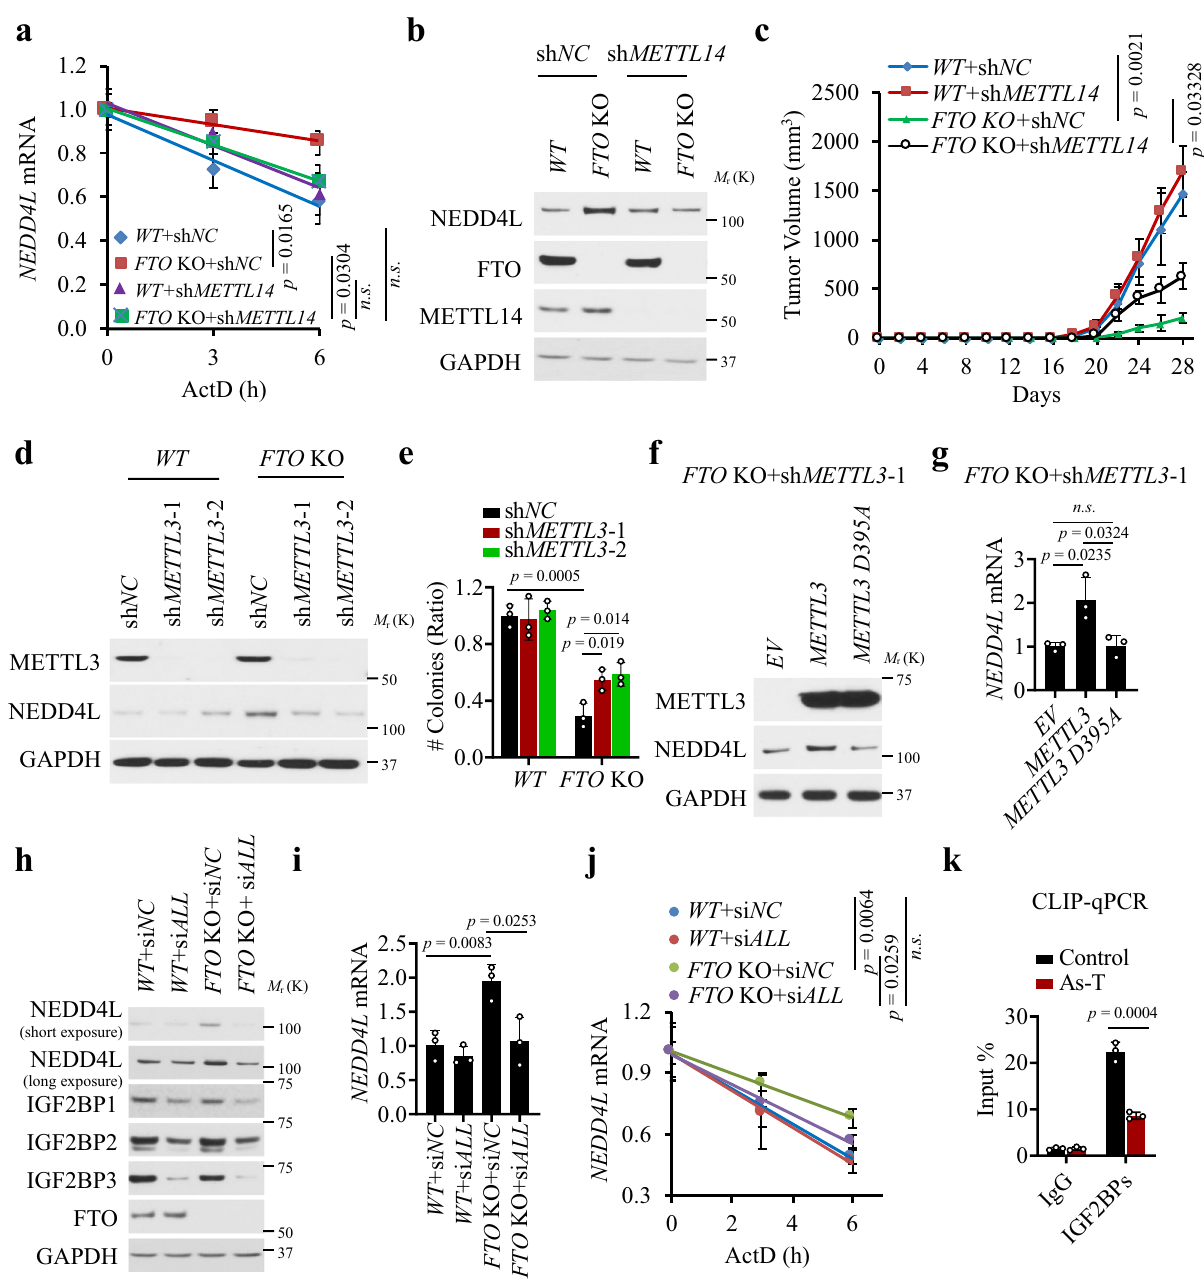
Fig. 5 FTO regulates NEDD4L and arsenic tumorigenicity through m 6 A. a qPCR analysis of NEDD4L mRNA stability in As-T cells with or without FTO deletion and/or METTL14 knockdown ( n = 3). b Immunoblot analysis of NEDD4L, METTL14, and FTO in cells as in a . c Tumor volume as in a following subcutaneous injection of cells as in a into NSG mice ( n = 4). d Immunoblot analysis of NEDD4L and METTL3 in As-T cells with or without FTO knockout and/or METTL3 knockdown. e Soft agar assay of cells as in d ( n = 3). f Immunoblot analysis of NEDD4L and METTL3 in cells with FTO deletion and METTL3 knockdown transfected with wild-type (WT) METTL3 or demethylase-inactive mutant METTL3 D395A . g qPCR analysis of NEDD4L mRNA level in cells as in f ( n = 3). h Immunoblot analysis of NEDD4L, IGF2BP1, IGF2BP2, IGF2BP3, and FTO in As-T cells with or without FTO deletion in combination with transfection with siRNA targeting negative control (si NC ) or all three IGF2BP1-3 (si ALL ). i qPCR analysis of NEDD4L mRNA level in cells as in h ( n = 3). j qPCR analysis of NEDD4L mRNA stability in cells as in h ( n = 3). k CLIP-qPCR showing the binding of IGF2BPs to the NEDD4L transcript in control and As-T cells ( n = 3). All data were performed on n ≥ 3 biologically independent samples. Error bars are shown as mean ± S.D. ( a , e , g , i – k ) or mean ± S.E. c p -values of all data by two-tailed unpaired t -test are